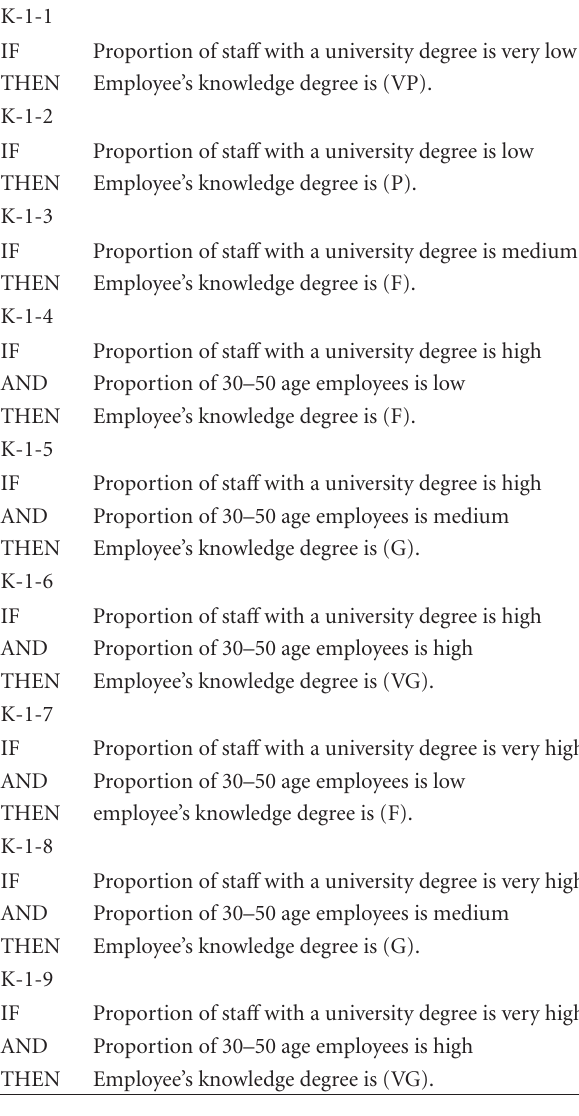
Table 1: Fuzzy rule set for employee’s knowledge performance